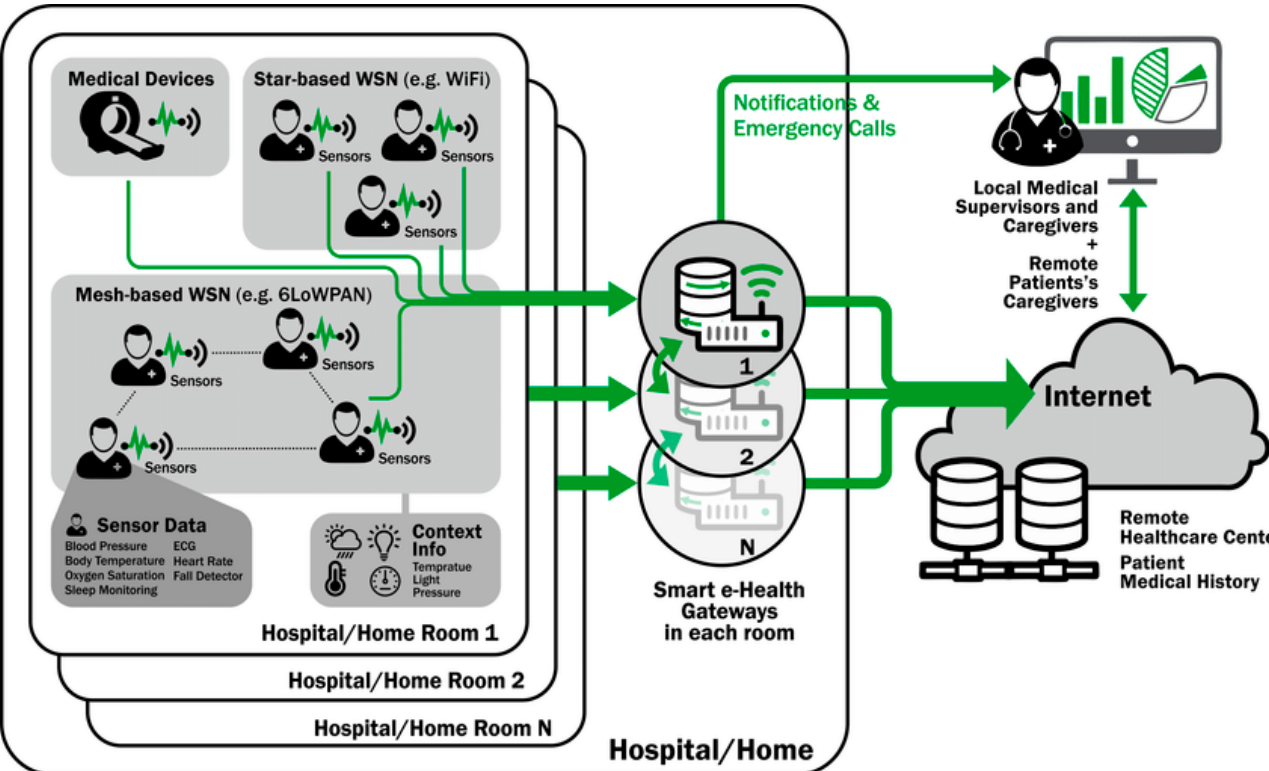
Figure 3. Proposed edge node sensors–IoT-based system.